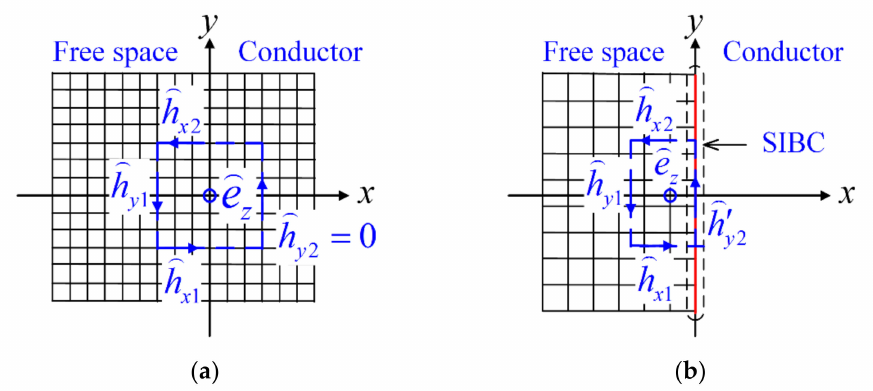
Figure 10. Comparison of grids without and with the surface impedance boundary condition (SIBC). ( a ) Without SIBC, ( b ) with